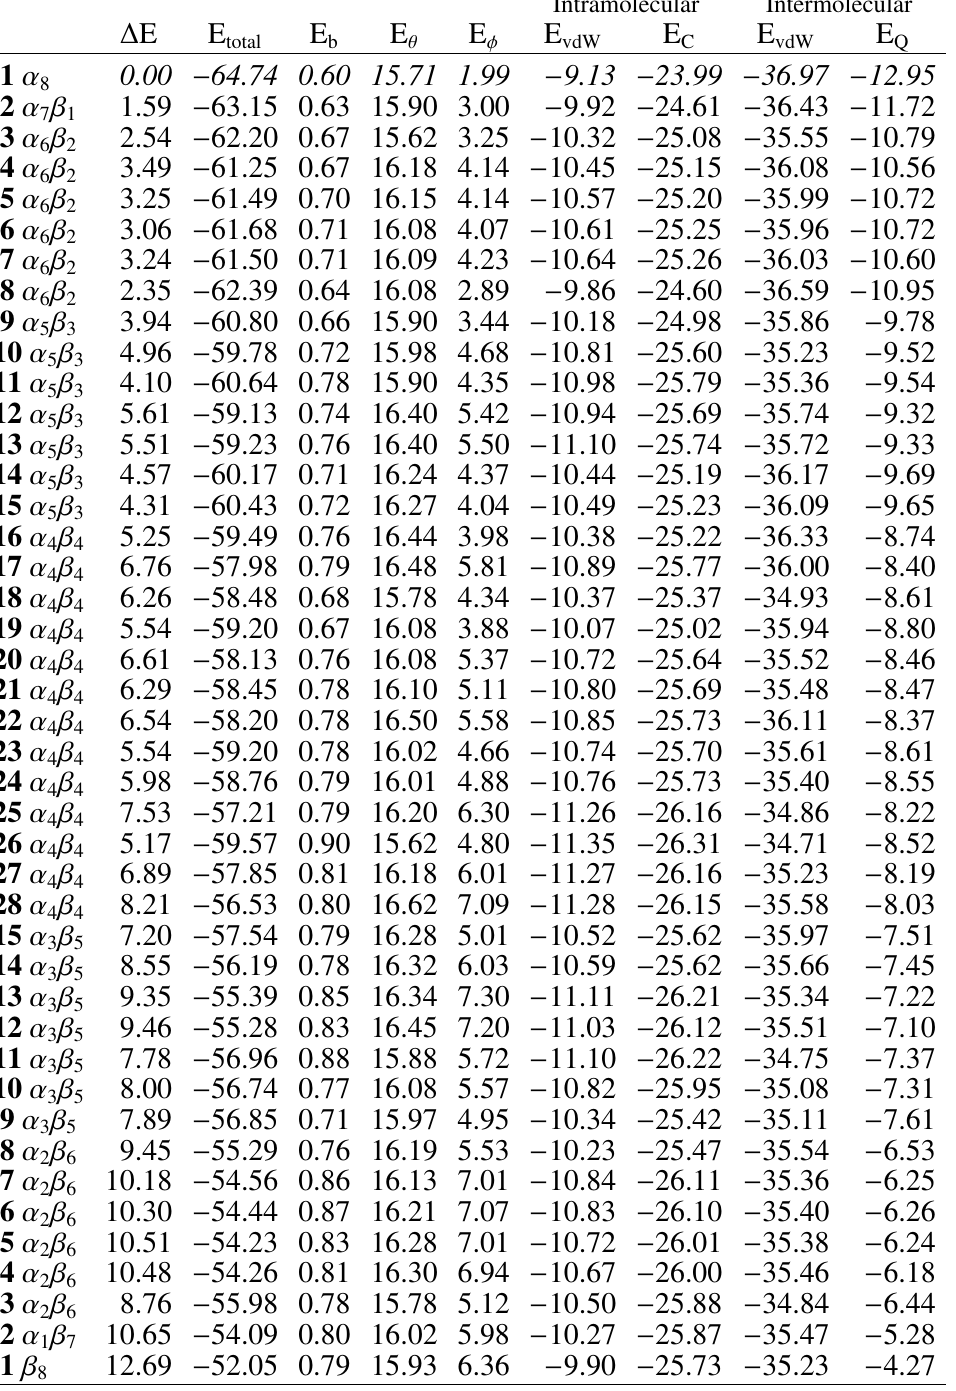
Table 2. Relative minimum energies ∆ E and energy contributions (in kcal / mol) from bond stretching (E ), angle bending (E ), torsional (E ), intra– and intermolecular van der Waals (E b θ φ Coulomb (E ), and intermolecular monopole–quadrupole (E C of Ni(OEP) adsorbed on the graphite(0001) surface. Data for the global minimum (conformer 1a ) are